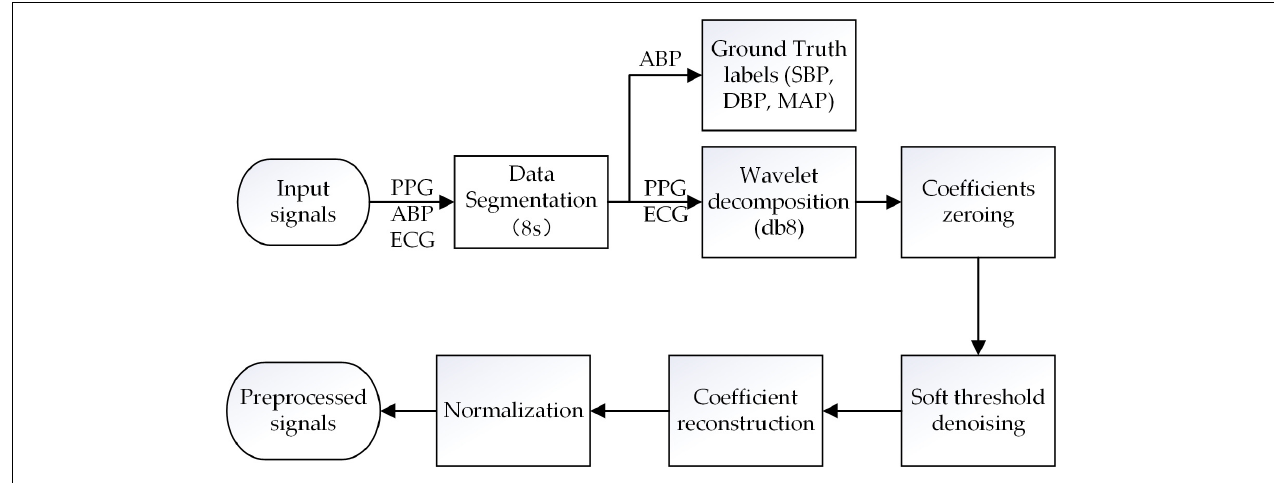
FIGURE 2 | Raw signals preprocessing pipeline.